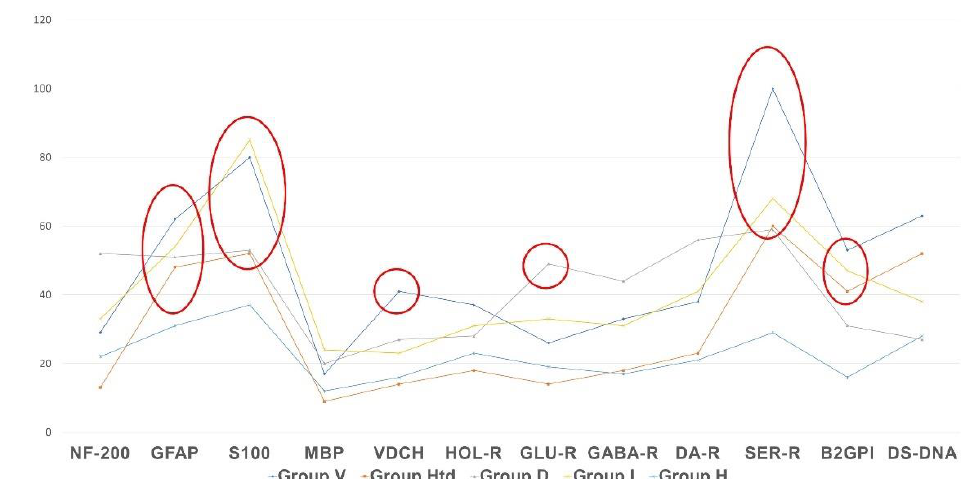
Figure 5. Profile of autoimmune reactivity to the neural and non-organ-specific visceral autoantigens in clinically significant chronic fatigue of various etiology, in comparison with control group. The absolute level of autoimmune reactivity in units of optical density is shown by the Y-axis. Statistically significant intergroup differences are outlined with ellipses or circles.